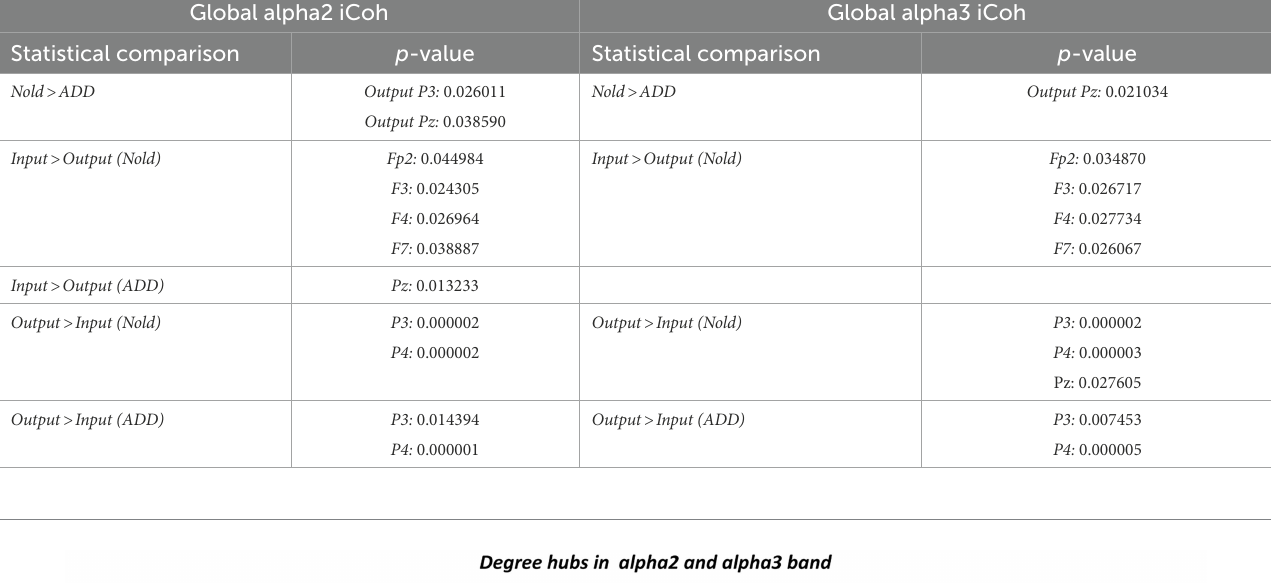
TABLE 2 Post-hoc p -values (Duncan test) relative to the ANOVA interaction effects on the global output and input isolated lagged effective coherence (iCoh) in the alpha 2 and alpha 3 bands.